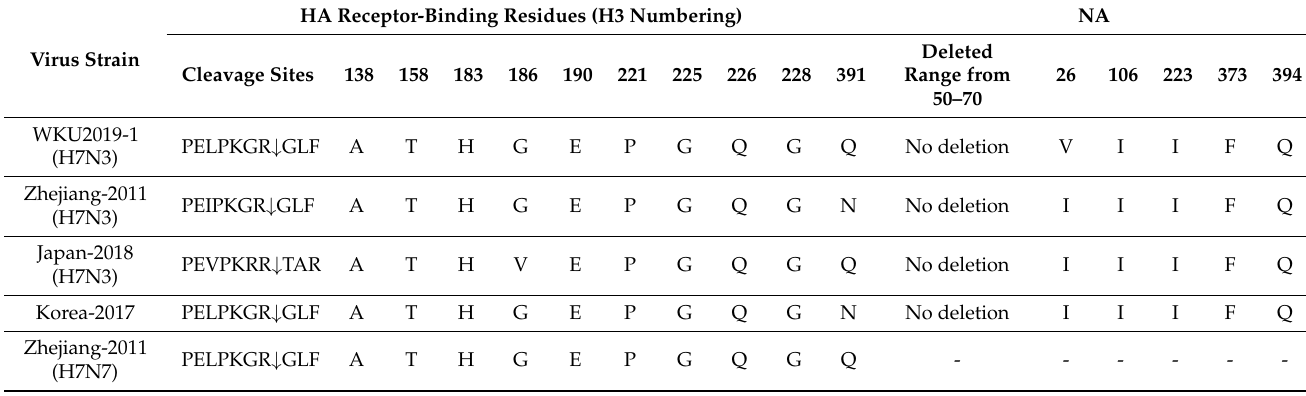
Table 2. Comparison of the hemagglutinin (HA) receptor-binding sites and neuraminidase (NA) gene segments of the novel avian H7N3 isolate and those of high and low pathogenicity avian H7N3 isolates. (“-”—no amino acid were found).